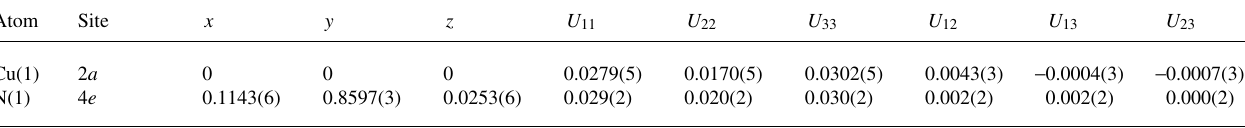
Table 3. Atomic coordinates and displacement parameters (in Å 2 )